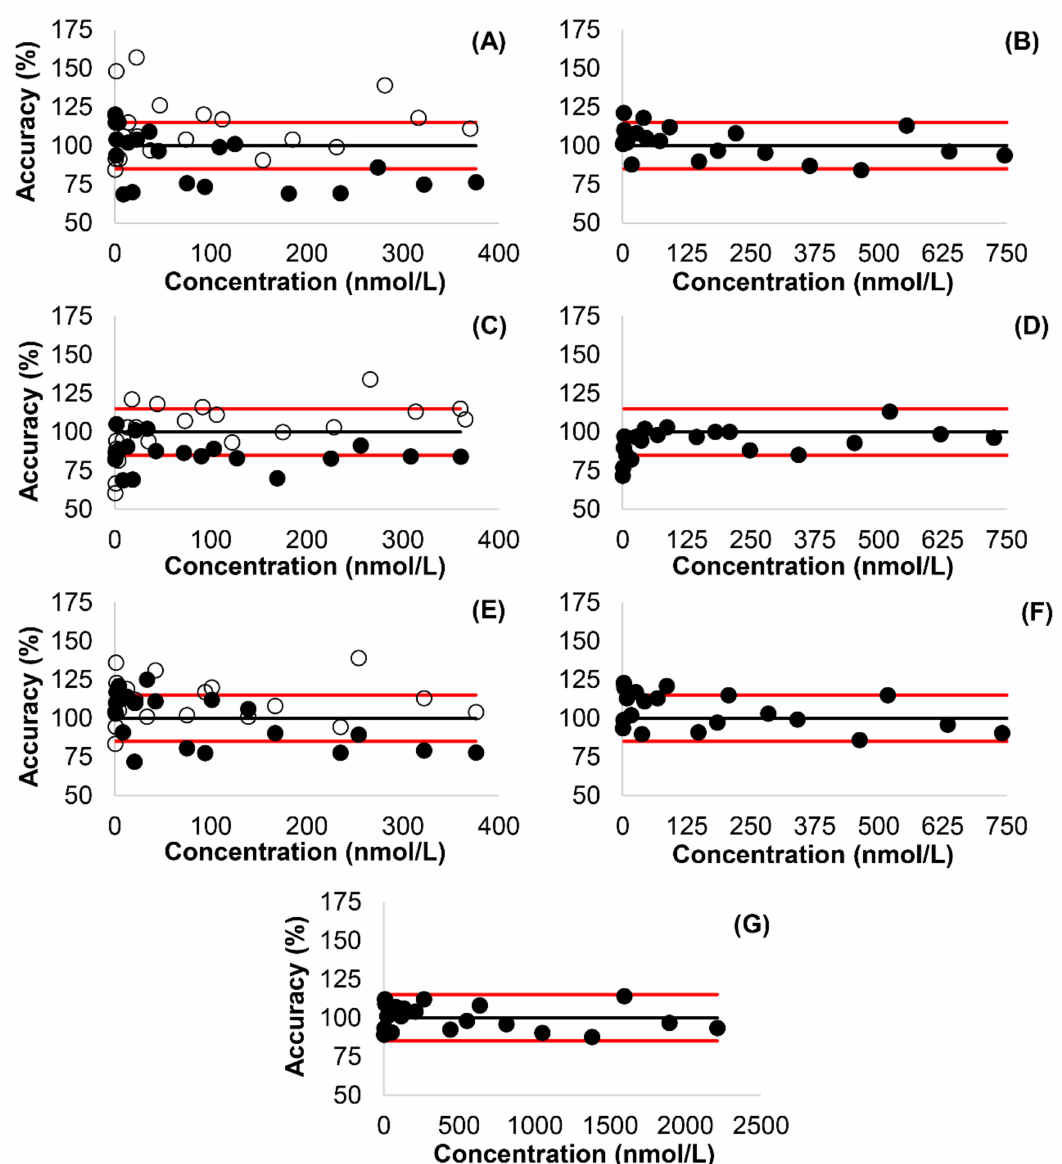
Figure 3. Accuracy of the presented method regarding individual analytes, sums of the concentrations of acid and lactone forms (ATR + ATRL), and the sums of the concentrations of all analytes (ATR + MET). Results obtained at 20 spiking levels, and by spiking 20 independent serum samples at each spiking level, are shown. The horizon- tal lines indicate an accuracy of 100% (black), 85% and 115% (red). ( A ) Atorvastatin (filled circles) and atorvas- tatin lactone (hollow circles). ( B ) Combined concentrations of atorvastatin and atorvastatin lactone (ATR + ATRL). ( C ) 2-hydroxyatorvastatin (filled circles) and 2-hydroxyatorvastatin lactone (hollow circles). ( D ) Combined concentrations of 2-hydroxyatorvastatin and 2-hydroxyatorvastatin lactone (2OATR + 2OATRL). ( E ) 4-hydroxyatorvastatin (4OATR) (filled circles) and 4-hydroxyatorvastatin lactone (4OATRL) (hollow circles). ( F ) Combined concentrations of 4-hydroxyatorvastatin and 4-hydroxyatorvastatin lactone (4OATR + 4OATRL). ( G ) Combined concentrations of all analytes (ATR +